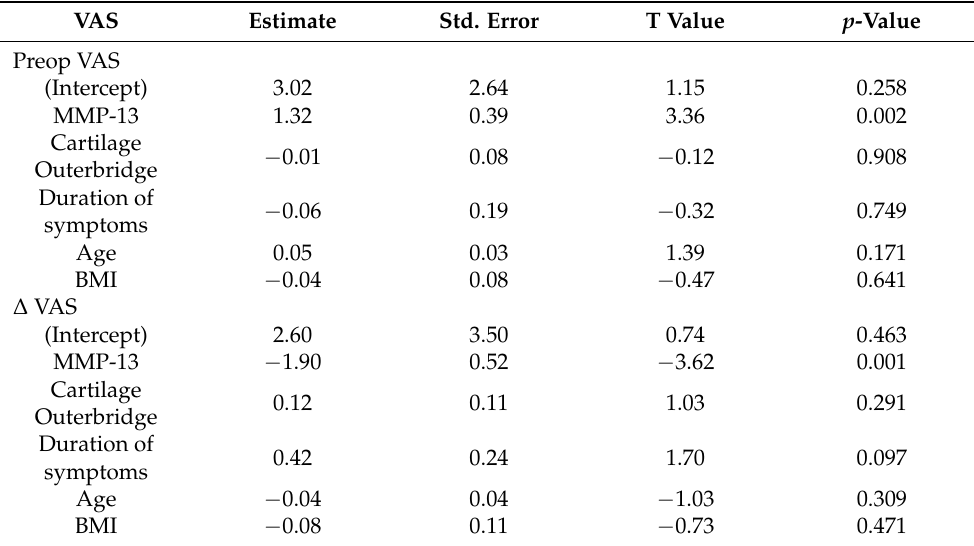
Table 4. Multivariate analysis between clinical outcomes (VAS and ∆ VAS) and the influence of MMP-13 and other variables as dependent